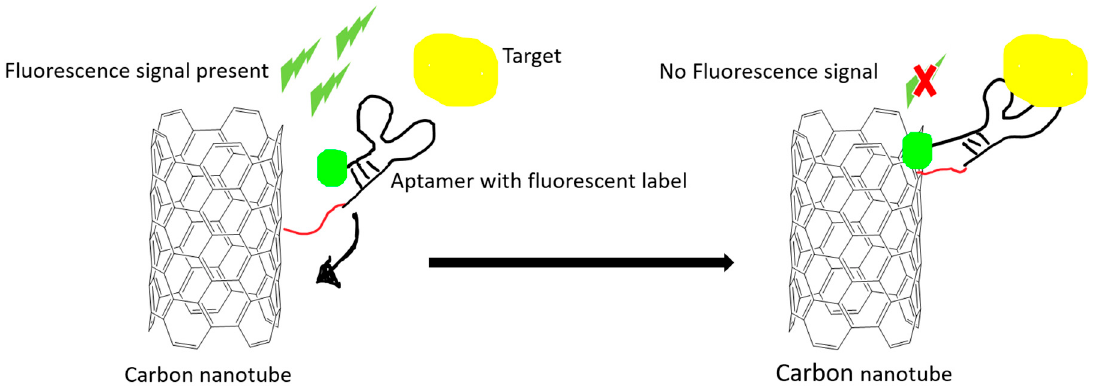
Figure 2. An example illustration of how carbon nanomaterials are used as a fluorescence quencher to turn off the signal. The fluorescence signal is quenched after the target-induced conformational change in the aptamer. The quenching effect is due to the Förster resonance energy transfer (FRET) effect.